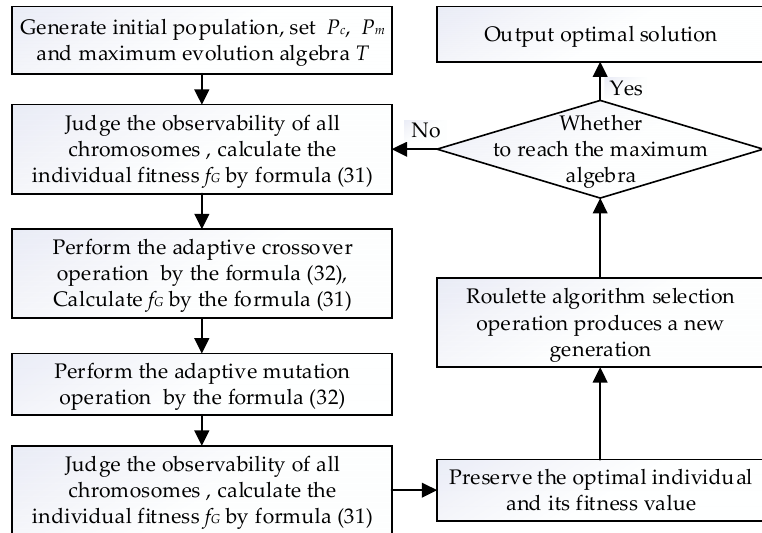
Figure 4. The solution process of the improved genetic algorithm.